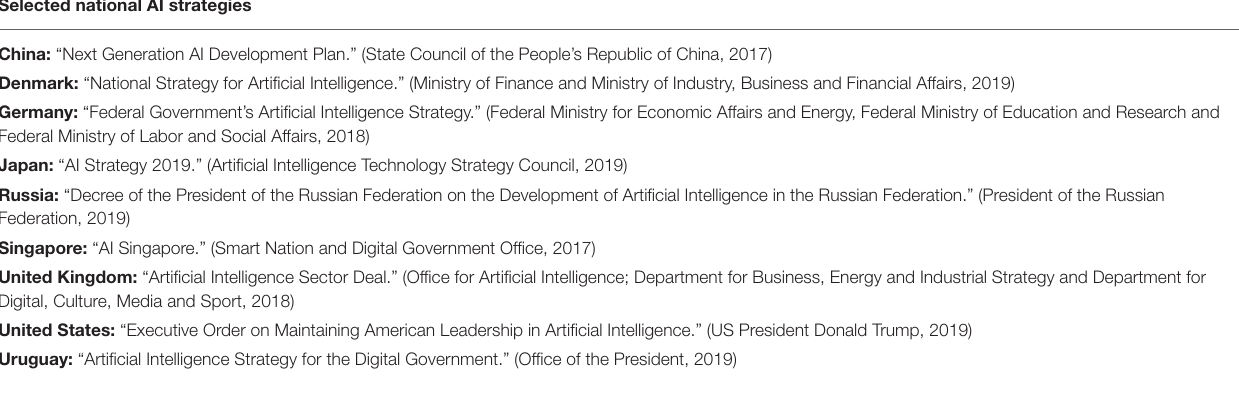
TABLE 2 | Selection of national AI strategies. Selected national AI strategies